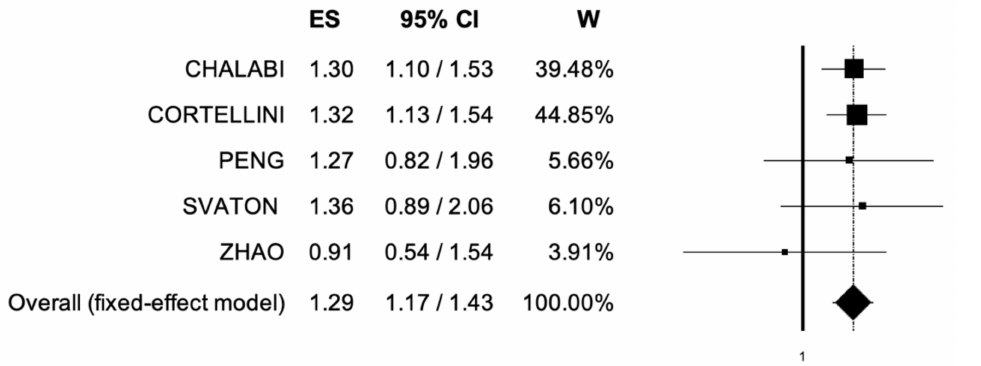
Figure 3. Forest plot of comparison between non-small cell lung cancer patients receiving immune checkpoint inhibitors with concomitant PPIs and/or H2RAs use or not; the outcome (ES) was Hazard Ratio of Progression-Free Survival. Abbreviations: CI: confidence interval; ES: Effect Size (Hazard Ratio); W: